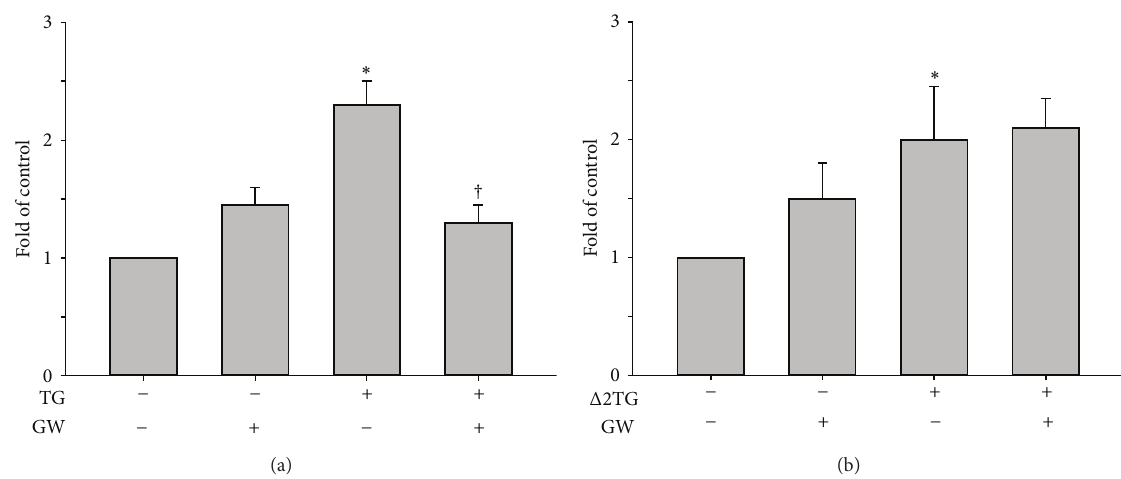
Figure 4: PPAR 𝛾 antagonist GW9662 abolished the TG-stimulated adiponectin mRNA expression and had no effect on Δ 2TG-enhanced adiponectin mRNA expression in THP-1 cells. Macrophages were incubated for 1h with 5 𝜇 M GW9662 (a PPAR 𝛾 inhibitor) and then for 18h with or without 9 𝜇 M TG (a) or Δ 2TG (b) in the continued presence of the inhibitor, and then, adiponectin mRNA expression was measured by quantitative RT-PCR. ∗ 𝑃 < 0.05 as compared to the untreated cells. † 𝑃 < 0.05 as compared to the TG or Δ 2TG-treated cells,